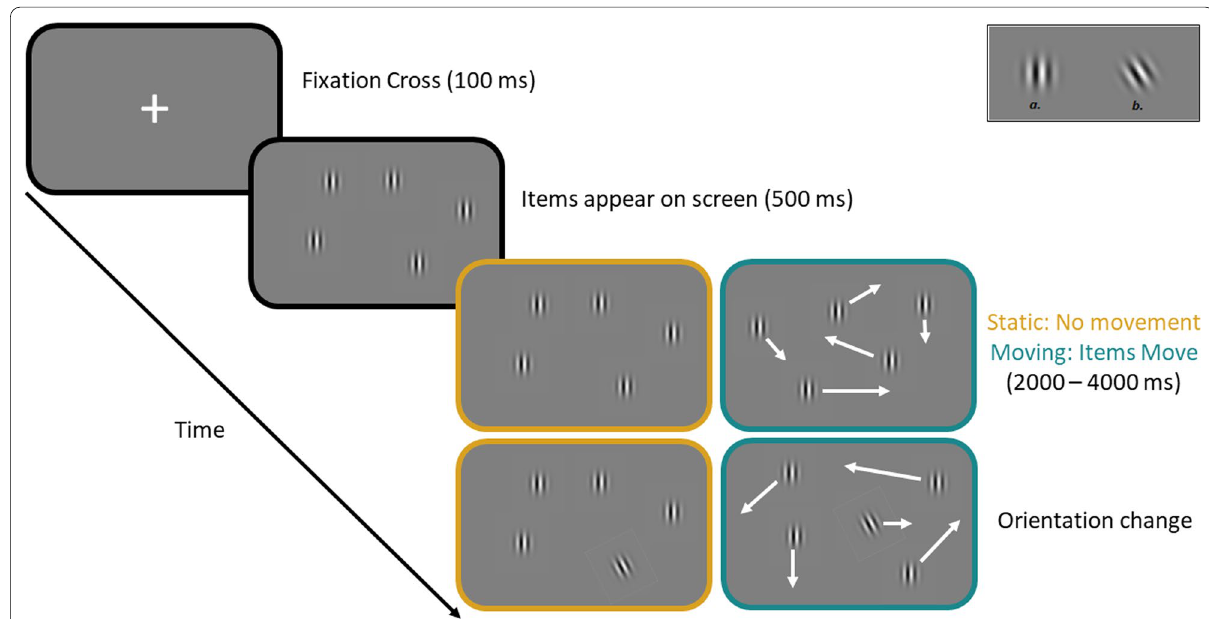
Fig. 1 Timeline of the task. Each trial beings with a fixation cross. The items then appear on screen for 500 ms. In the static condition (golden screen), the items do not move. In the moving condition (turquoise screen), the items move around the screen. After a random interval between 2,000 and 4,000 ms, one item will undergo an orientation change. The panel in the top right shows the starting orientation of all items ( a ) and the rotated orientation of the target item ( b )